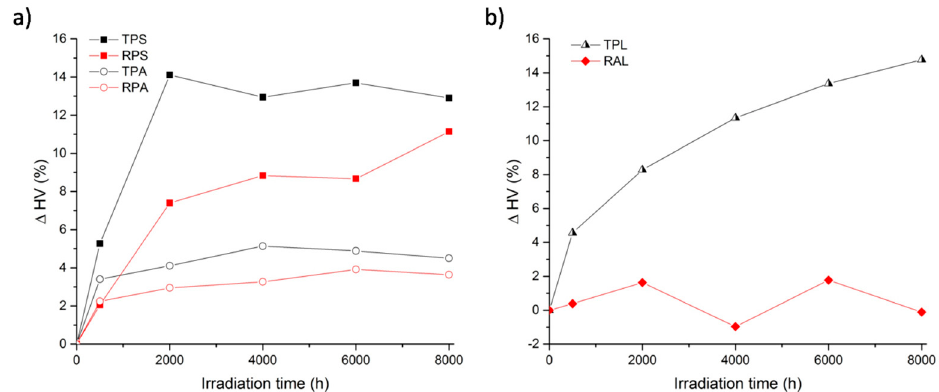
Figure 11. Vickers hardness values variation versus irradiation time for: ( a ) Reference samples (TPS,